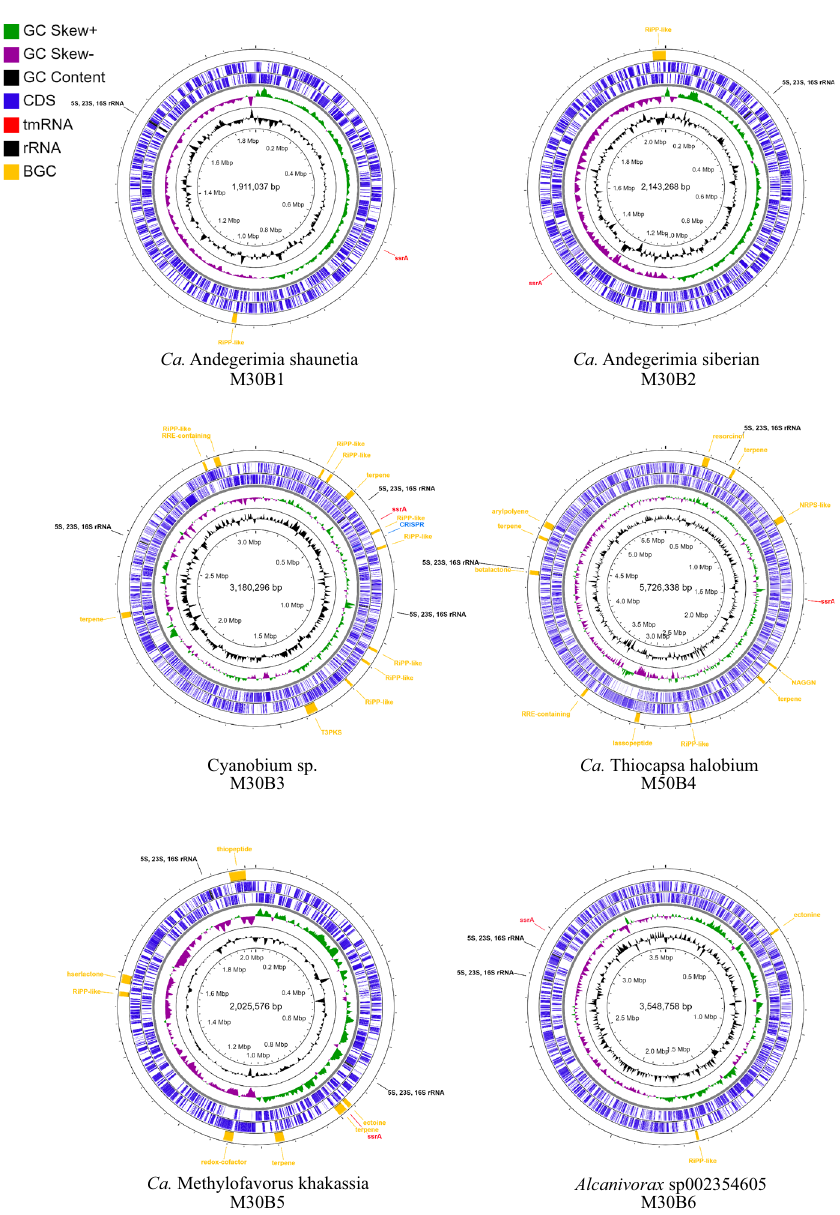
Fig. 4 Representation of the six complete MAGs. The rings from the inside to outside represent GC content (black), GC skew- (purple), and GC skew + (green). The next two blue rings represent coding sequences on the forward and reverse strands, respectively. On the outmost ring are the rRNA gene sequences (black), transfer-messenger RNA (red), and secondary metabolite gene clusters (yellow). MAG ID M30B6 is classi fi ed as Alcanivorax sp002354605, M30B1 and M30B2 are Simkaniaceae sp., M30B3 is Cyanobium sp., M30B5 is “ Methylofavorus khakassia ” ., and M50B4 is “ Thiocapsa halobium ”